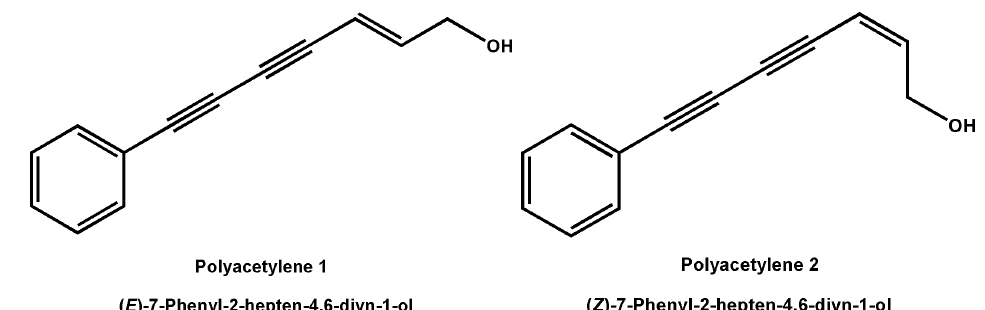
Figure 1. Structures of polyacetylenes 1 and 2 .